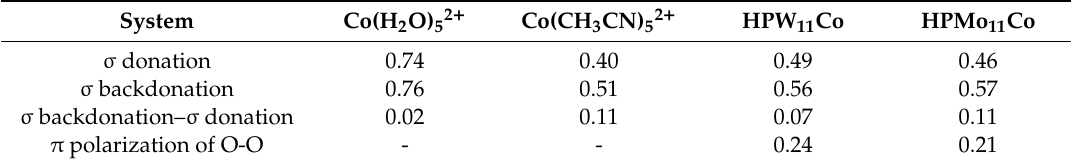
Table 2. NOCV-eigenvalues describe the σ -donation, σ -backdonation, and π -polarization processes observed as a result of the interaction between the studied systems and the O 2 molecule.